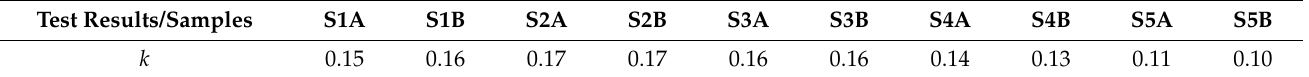
Table 6. Permeability test results of the produced concrete specimens.